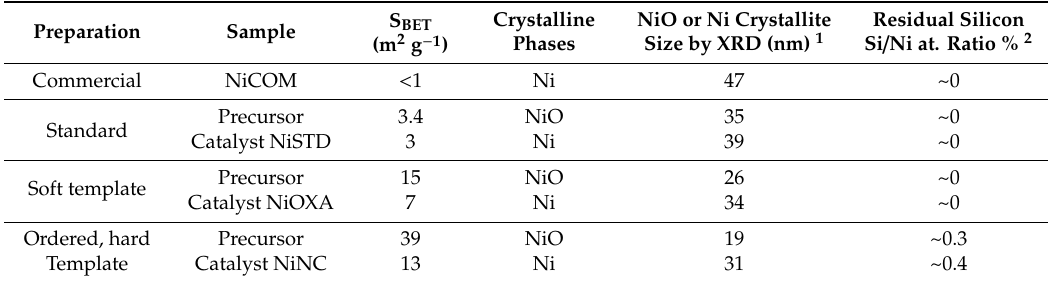
Table 1. Characteristics of the nickel oxide precursors and final reduced nickel catalysts.